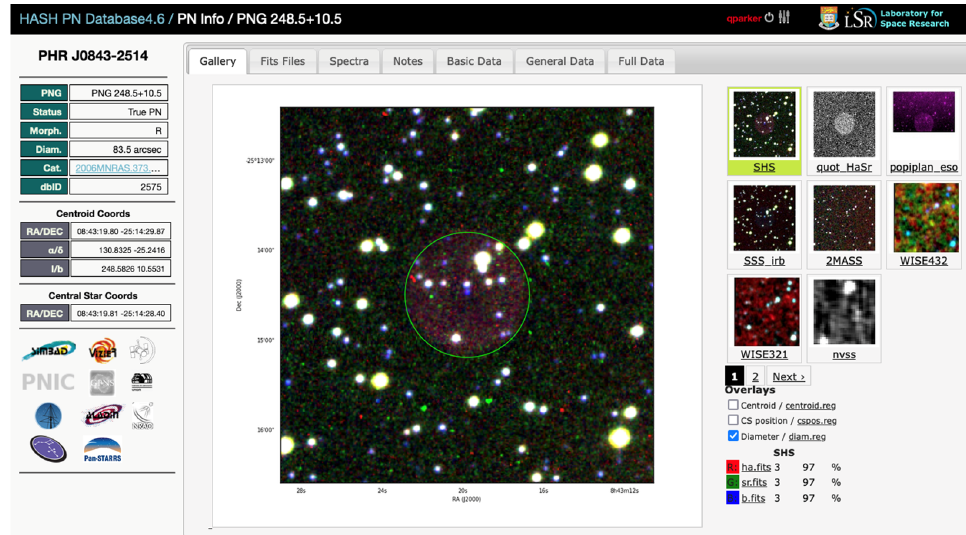
Figure 4. HASH database page for PN PHR J0843 − 2514 showing the faint round PN and newly identified very faint blue CSPN at its geometric center. Some of the high-level functionality of HASH can be appreciated in this page in terms of external surveys accessed by clicking on the icons on the bottom left of the main HASH image page and the tab selection options at the top that allow online access to the fits images, spectral plots, basic data and more. Table 3. This table shows which available HASH imagery was used to uncover 332 of the 415 newly identified CSPN. For the other 83 cases, combinations of available image data were used.